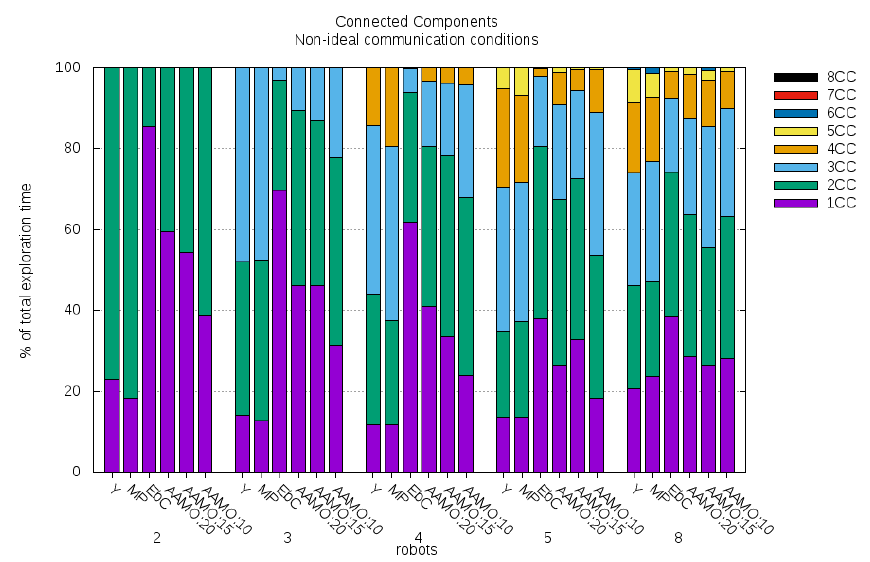
Figure 26. Network topology composition under non-ideal communication conditions averaged over time. Depending on the number of connected components and the fleet size, it is possible to study the existence of sufficient conditions to fall into isolation situations. For instance, for a 3-Robot fleet, the 2CC or 3CC topologies imply having at least one robot isolated while for a 5-Robot fleet this implication is related to 3CC, 4CC, or 5CC topologies, and so